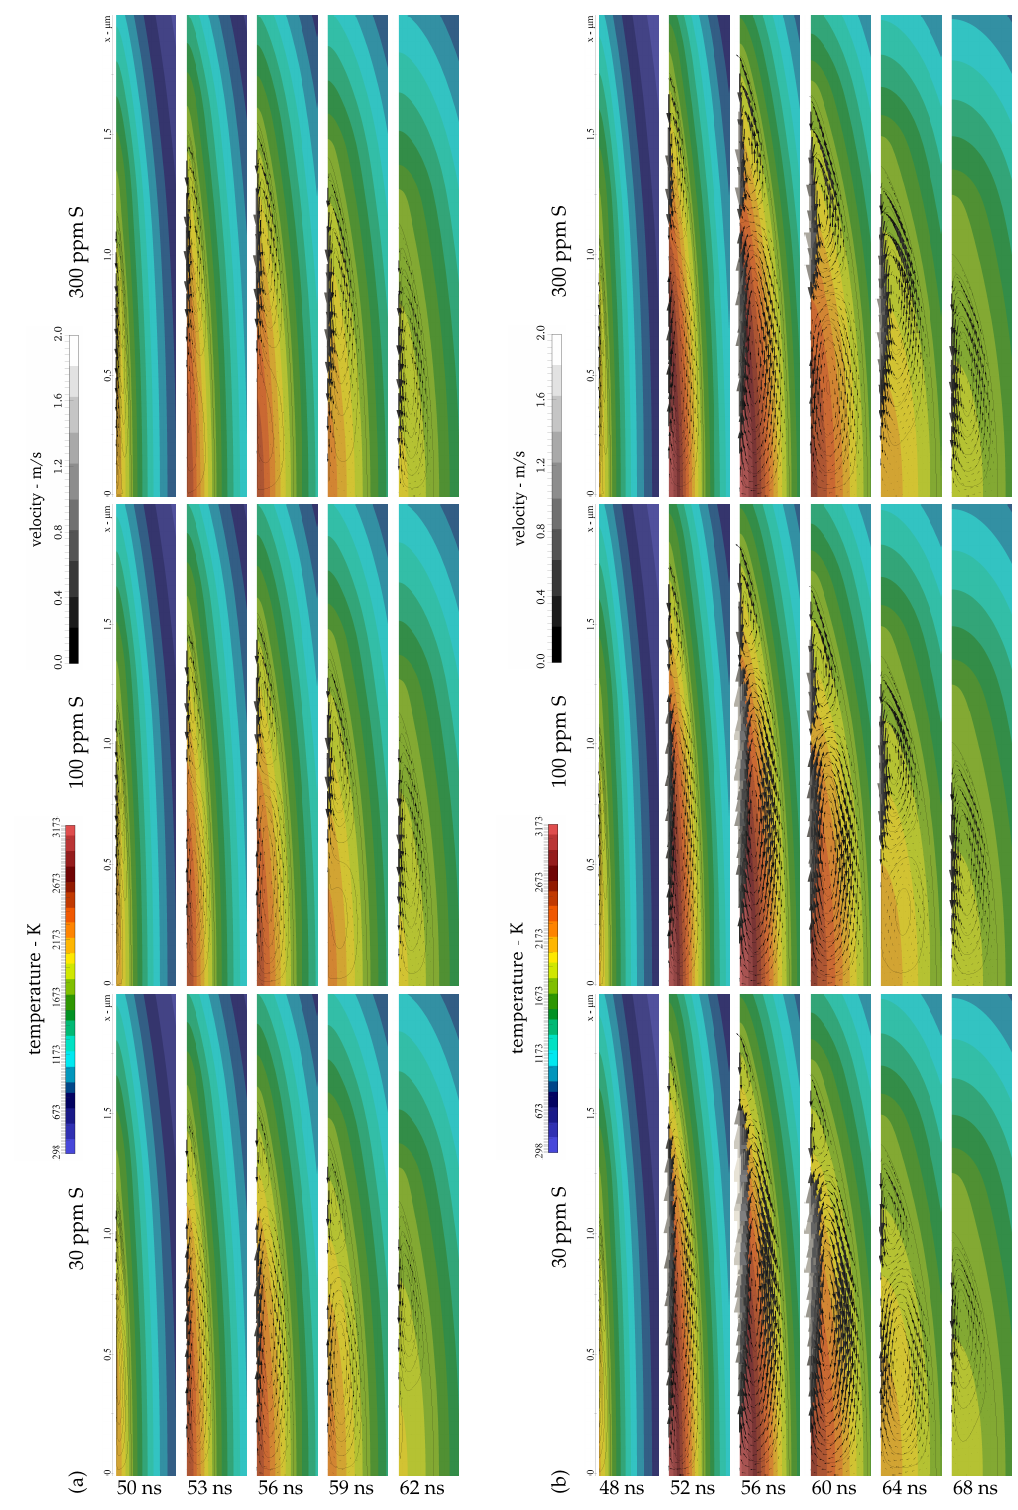
Figure 12. Simulation of melt pool flow during DLIP ( λ = 1053 nm, Λ = 7.2 µm, and τ p = 12 ns) of steel with (l) 30 ppm, (c) 100 ppm, and (r) 300 ppm sulphur at a laser fluence of ( a ) 2 Φ 0 = 0.532 J/cm 2 and ( b ) 2 Φ 0 = 0.665 J/cm 2 with detail of 2 µm × 250 nm including isotherms, streamlines, and velocity vectors in melt pool half width at times ( a ) t = 50 ns, 53 ns, 56 ns, 59 ns, and 62 ns, and ( b ) t = 48 ns, 52 ns, 56 ns, 60 ns, 64 ns, and 68